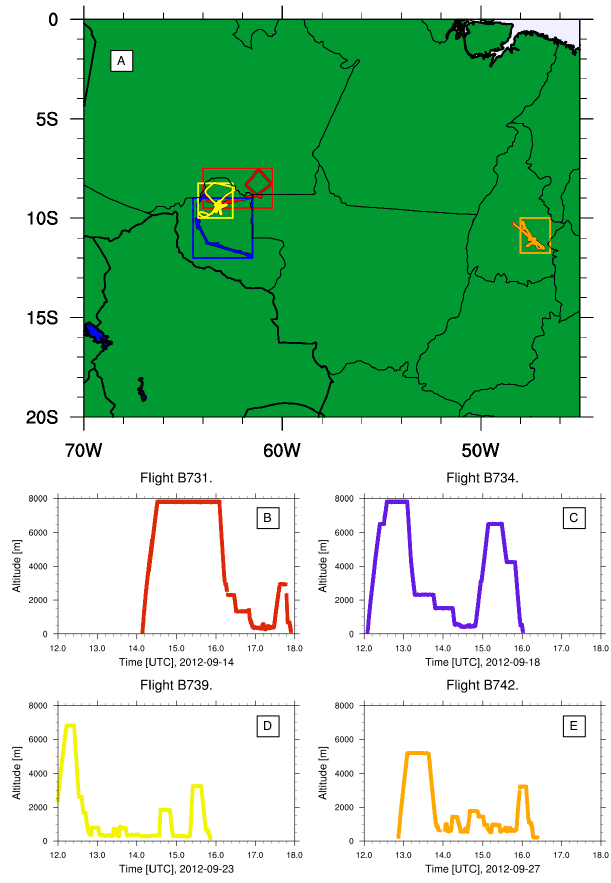
Figure 7. (a) Map of SAMBBA flight trajectories. Red: B731, 14 September 2012. Blue: B734, 18 September 2012. Yellow: B739, 23 September 2012. Orange: B742, 27 September 2012. Lines show the path taken by flights, boxes show regions in model averaged over when comparing between model and flight data. (b–e) , altitude tracks of the four flights used for case